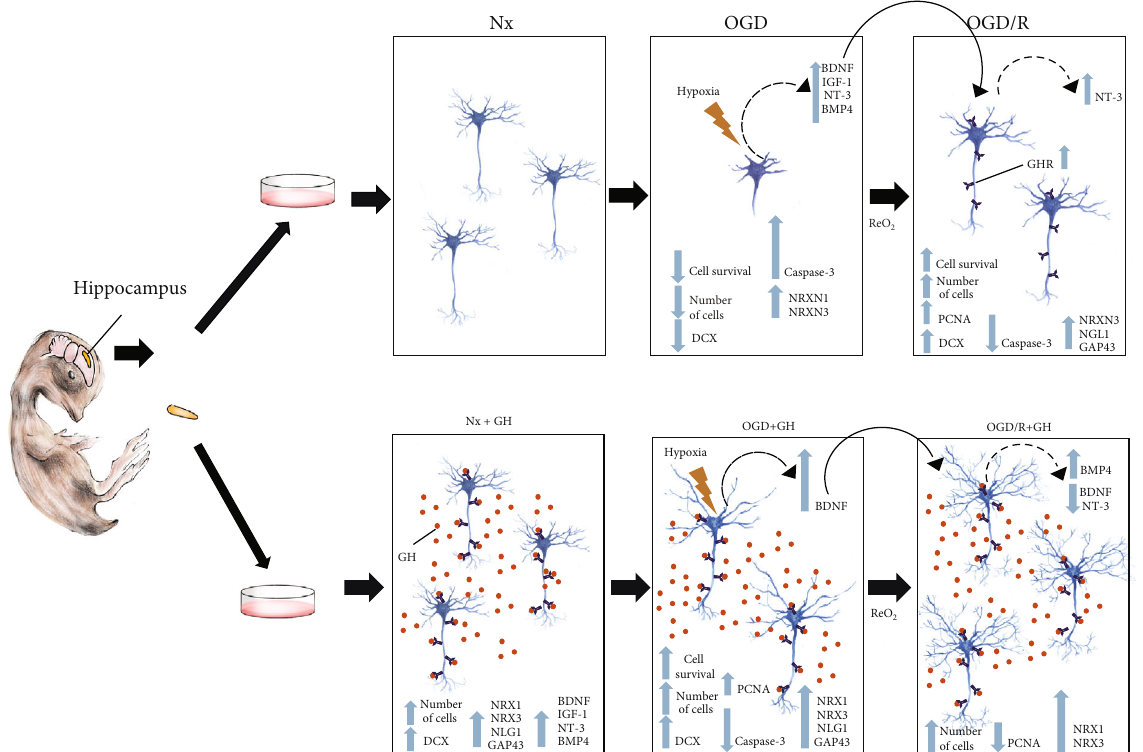
Figure 10: Infographic showing the e ff ects of growth hormone (GH) on neuroprotection and neuroplasticity after OGD and reoxygenation (OGD/R) incubation conditions. Primary hippocampal neuron cultures obtained from chick embryos were maintained under normoxia conditions (Nx) for 5 days. Cell cultures were then exposed to oxygen-glucose deprivation (OGD) conditions for 24 h and then incubated under reoxygenation (OGD/R) conditions for another 24h. Exposure to OGD injury signi fi cantly augmented apoptosis (caspase-3 activity) and reduced neurite outgrowth, cell survival, number of cells, and doublecortin immunoreactivity (DCX-IR), whereas the expression of synaptogenic markers (NRXN1, NRXN3) and neurotrophic factors (BDNF, NT-3, IGF-1 and BMP4) was increased. On the other hand, exposure of the harmed cultures to reoxygenation (OGD/R) triggered endogenous mechanisms that reversed most of the adverse e ff ects of OGD and increased the expression of NT-3 and GHR. Treatment with growth hormone (GH) enhanced cell survival and neural plasticity in all incubation conditions, protecting the cultures from harm. Under Nx condition, GH addition (Nx + GH) increased the number of neurites, number of cells, DCX-IR, and expression of synaptogenic markers NRX1, NRX3, NLG1, and GAP43. Remarkably, treatment during OGD injury (OGD + GH) signi fi cantly reduced apoptosis, protected dendrites and neurites of hippocampal neurons, and signi fi cantly increased the level of several parameters, such as cell survival, the number of cells, DCX-IR, and PCNA expression, above those observed in the OGD/R condition. Also, GH stimulated the expression of BDNF and the synaptogenic markers NRXN1, NRXN3, NLG1, and GAP43. Furthermore, during the reoxygenation stage (OGD/R + GH), GH induced and enhanced plastic changes re fl ected in a signi fi cant increase in the number, length, and branching of the neurites, as well as in the expression of BMP4, NRX1, and NRX3, while the expression of PCNA, BDNF, and NT-3 was